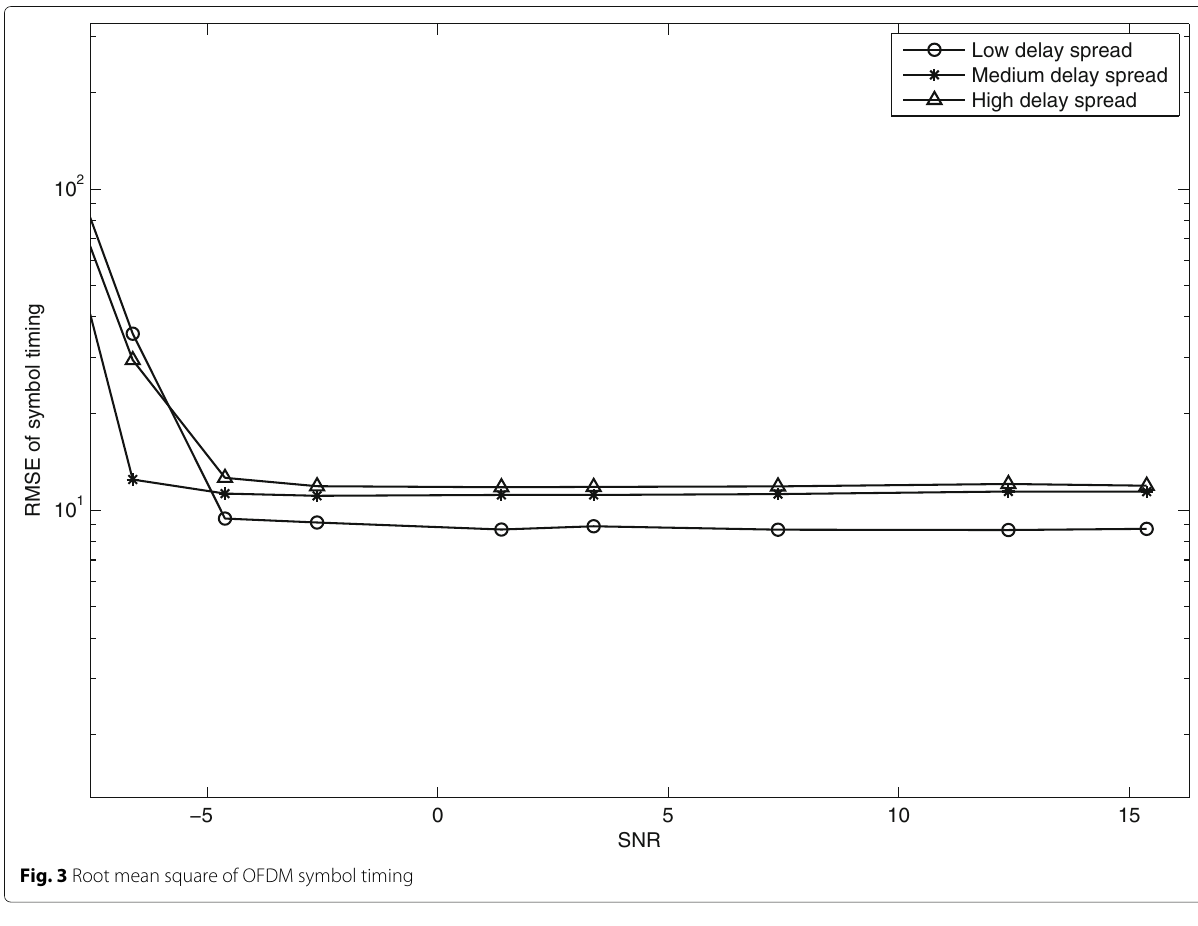
Fig. 3 Root mean square of OFDM symbol timing